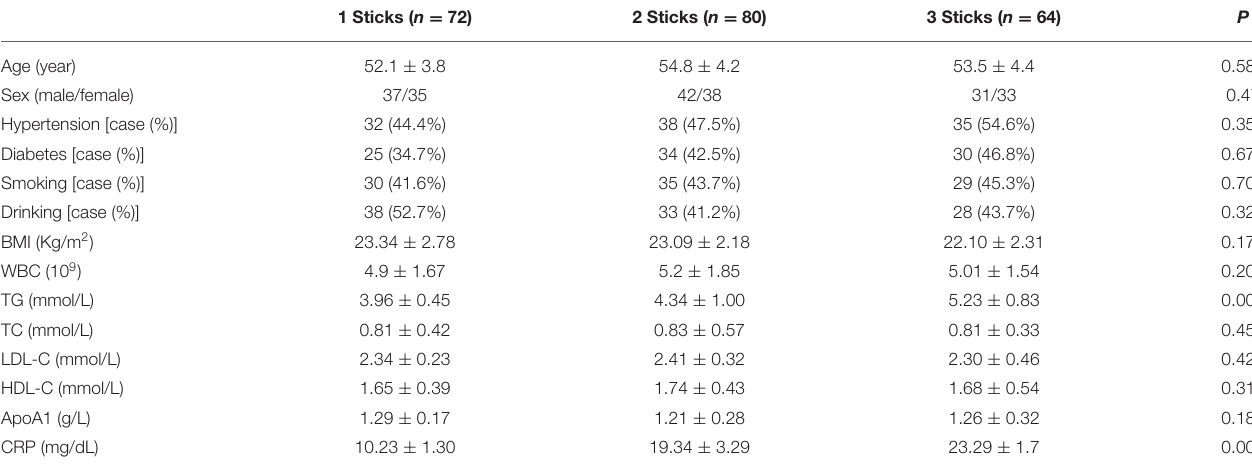
TABLE 2 | Analysis of clinical data in the grouping of the number of branches of coronary lesions.